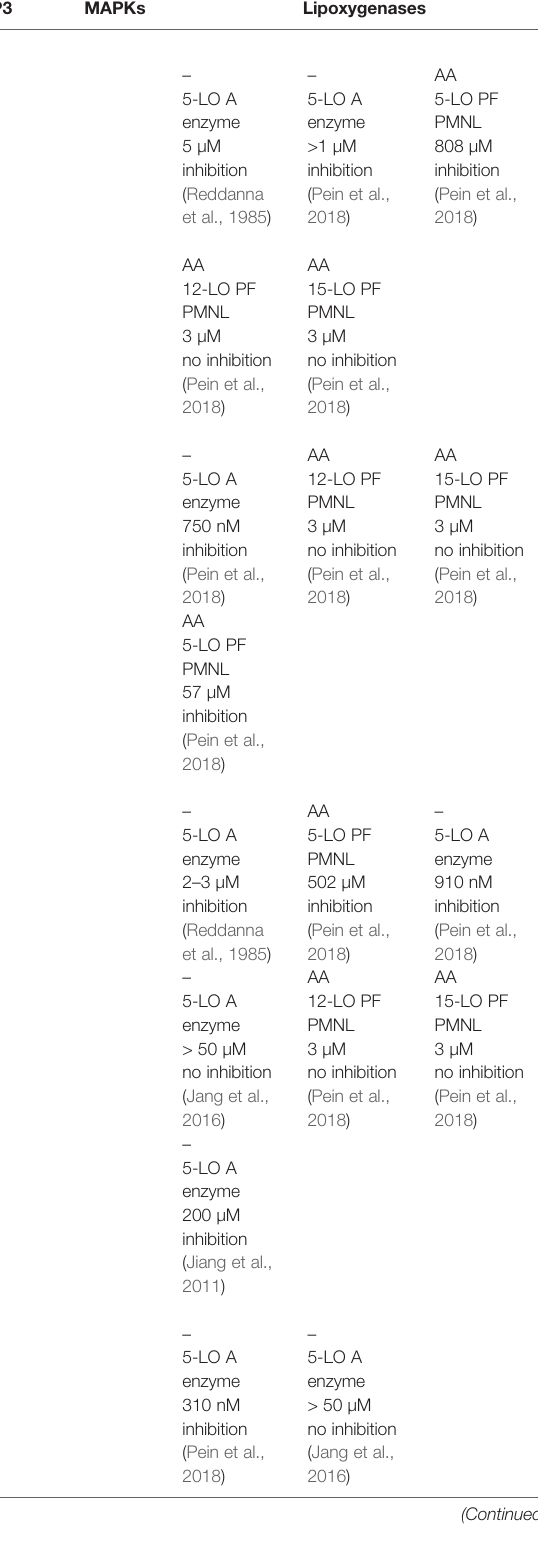
TABLE 4 | Overview on the interference of chromanols with molecular targets and key enzymes connecting in fl ammation and